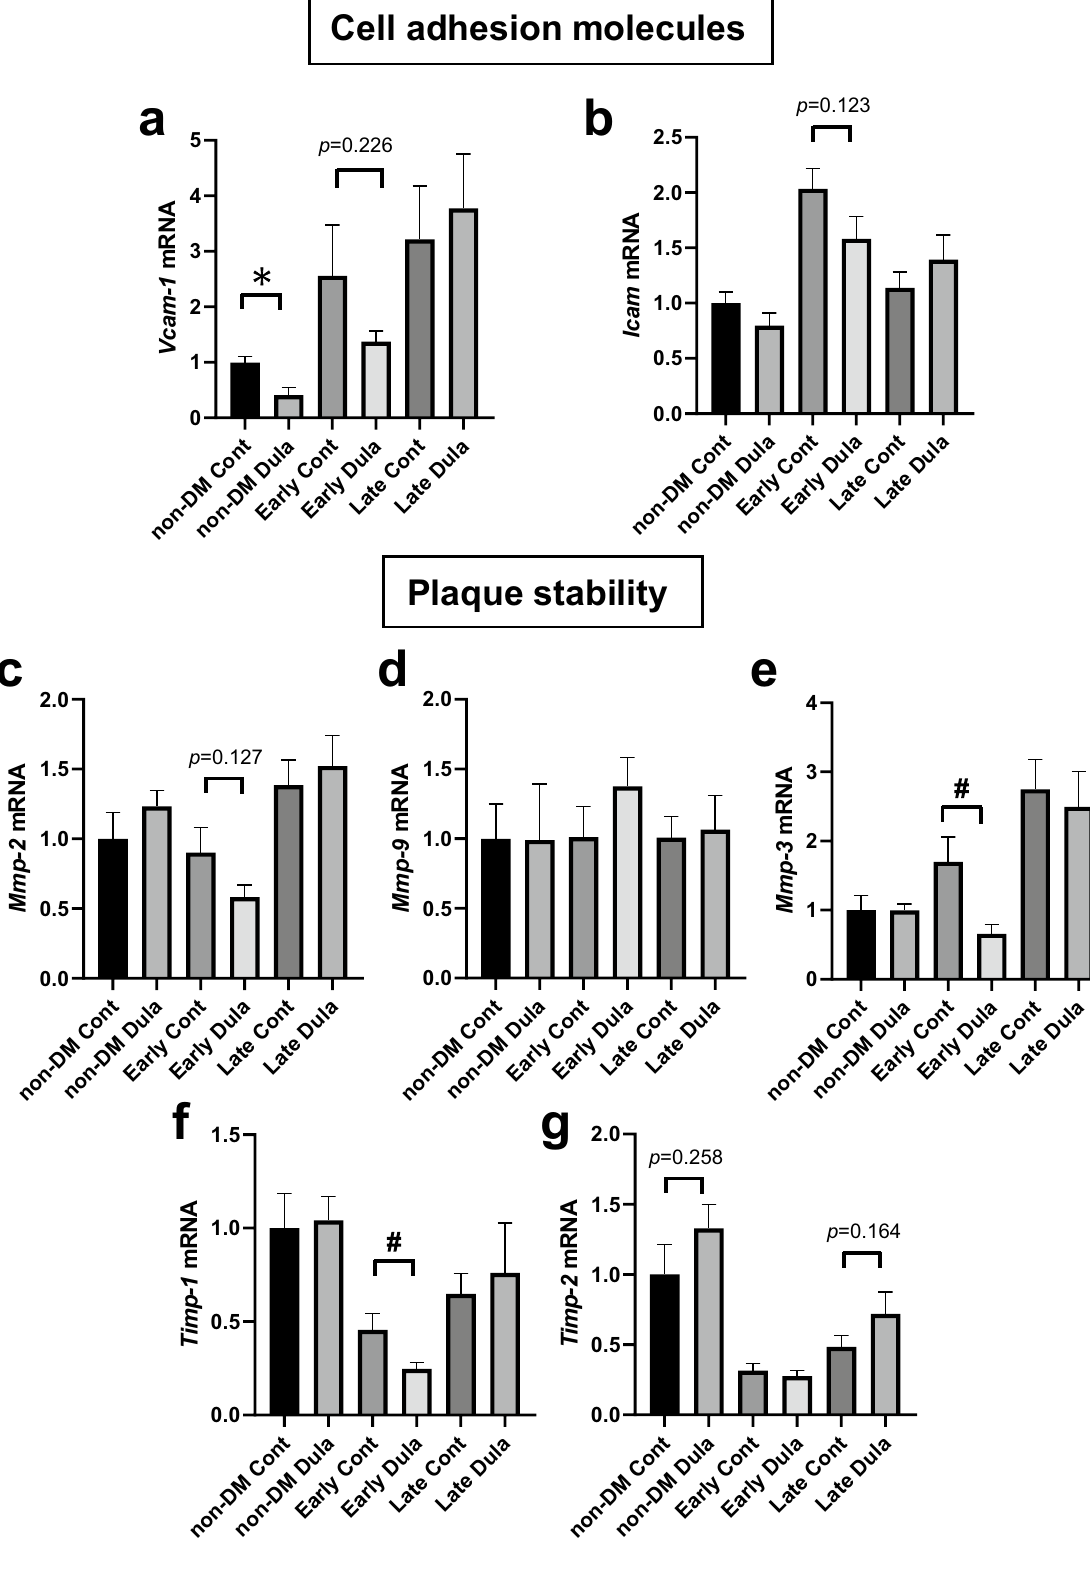
Figure 5. mRNA expression levels related to cell adhesion molecules and plaque stability in abdominal aorta. ( a , b ) mRNA expression levels related to cell adhesion molecules such as Vcam-1 and Icam . ( c – g ) mRNA expression levels related to plaque stability such as Mmp-2, Mmp-9, Mmp-3, Timp-1 and Timp2 expressed as fold change relative to non- diabetic control group. Non-diabetic Cont (n = 8), Non-diabetic Dula (n = 8), Early diabetic Cont (n = 8), Early diabetic Dula (n = 6), Late diabetic Cont (n = 8), Late diabetic Dula (n = 7). Values are the mean ± SEM of data obtained from each group. * p < 0.05 (non-DM Cont vs non-DM Dula), # p < 0.05 (Early Cont vs Early